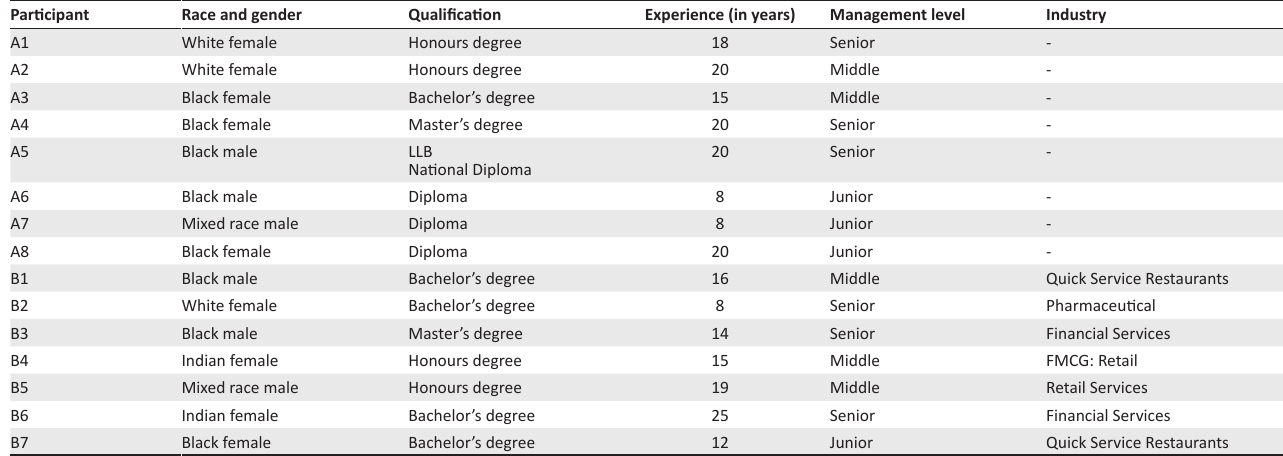
TABLE 1: Profile of